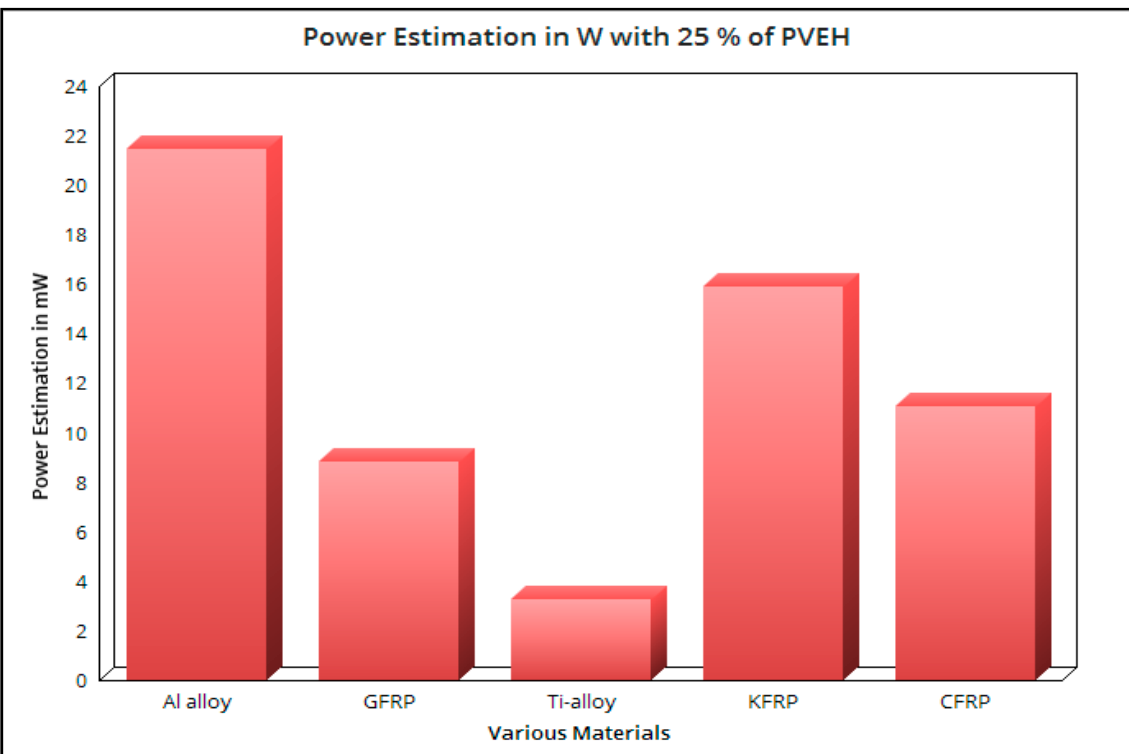
Figure 42. Power (P 0 ) in W with 50% attachment coverage-UAV wing.